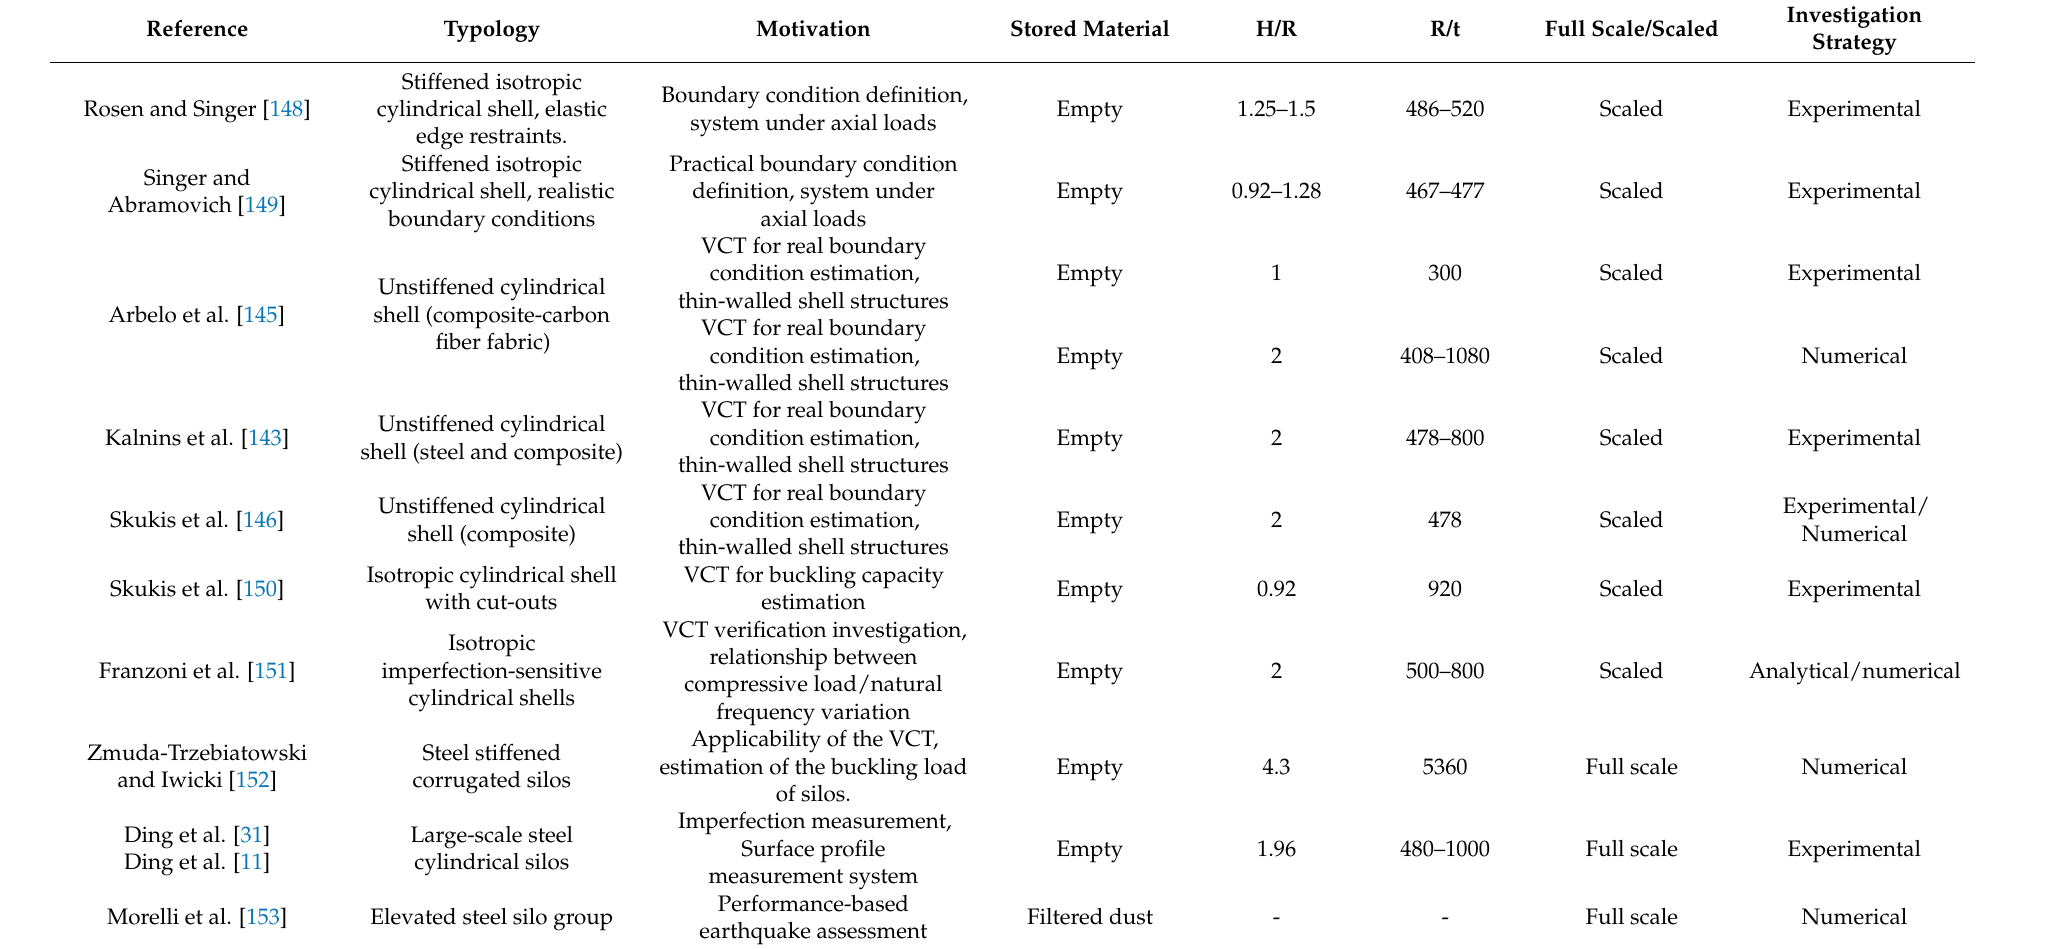
Table 4. Main failures modes and causes of silos of silos. H, R, and t indicates the height, the radius, and the thickness of the